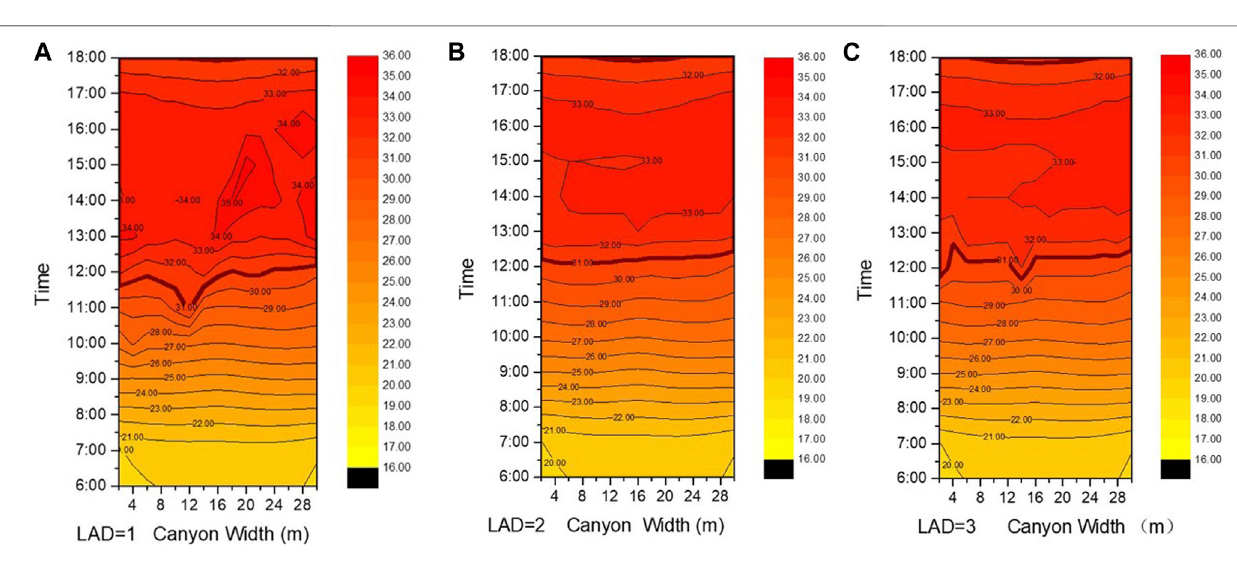
Frontiers in Environmental Science |